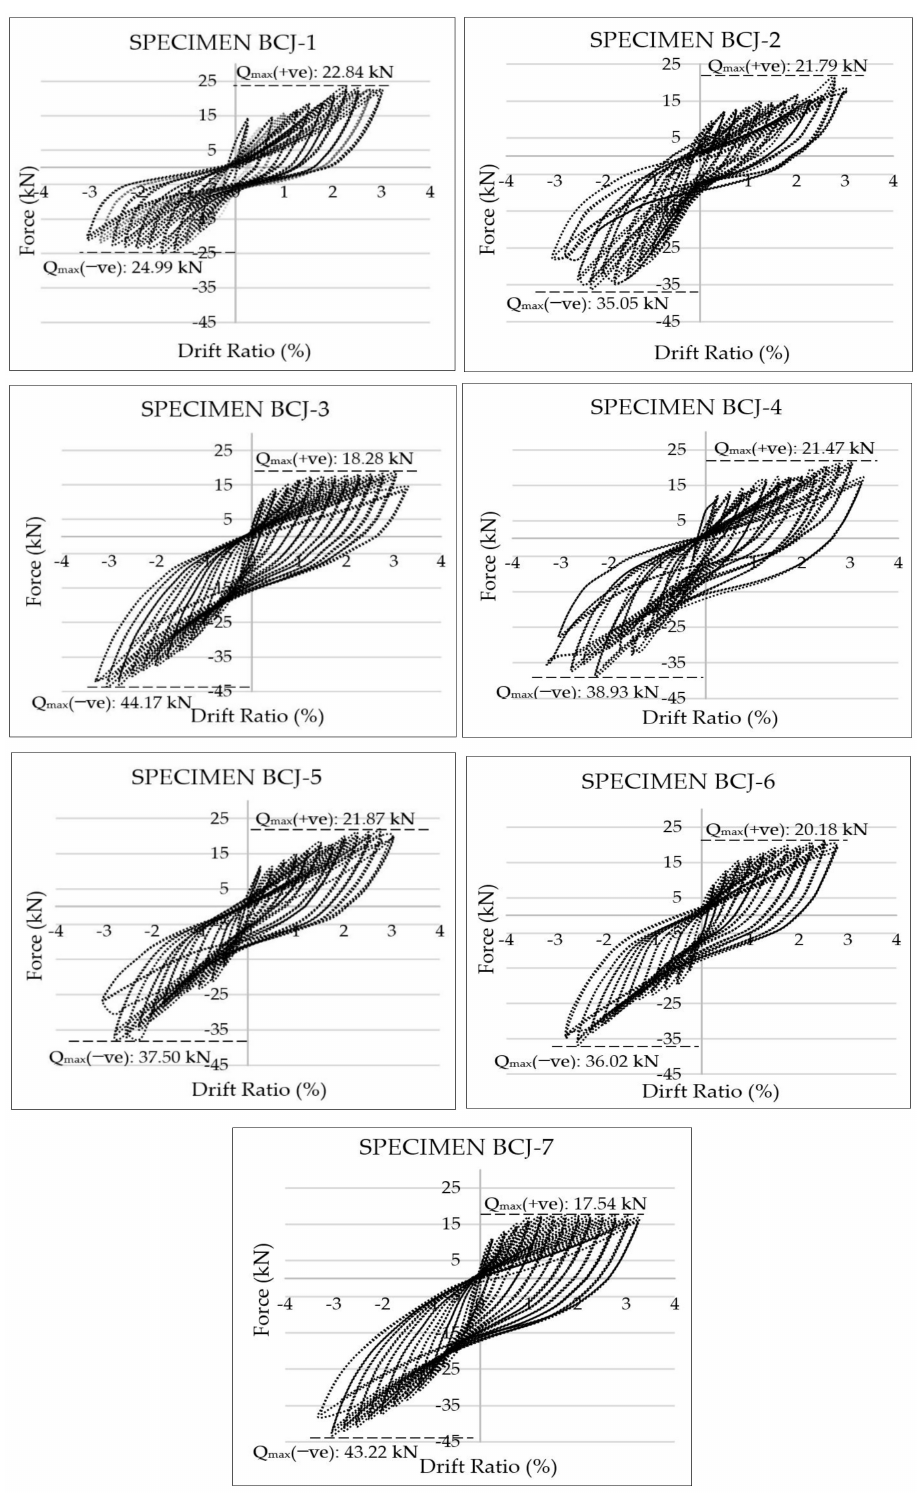
Figure 4. Load-drift hysteretic relationships of test